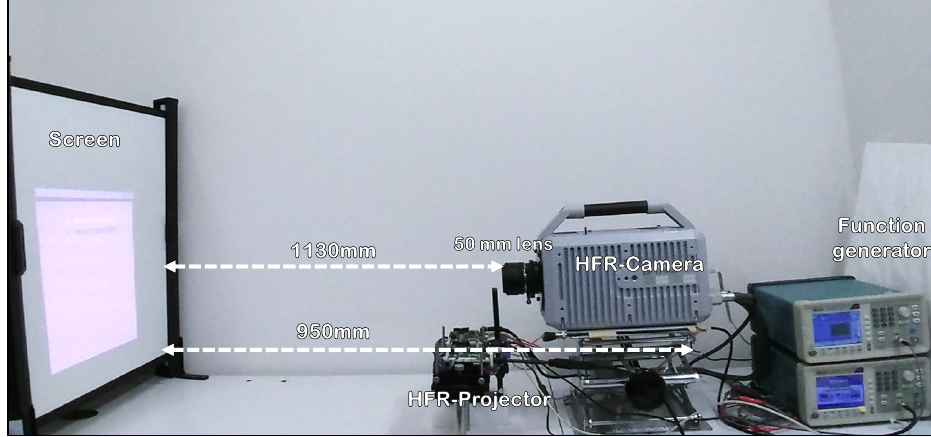
Figure 16. Overview of the HFR projector–camera